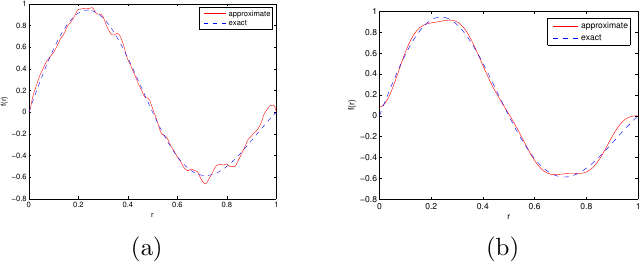
Figure 2. Example 1: (a) results by M2 with ˜ α = 1 ∗ 10 − 7 , (b) Result by M1 with M =